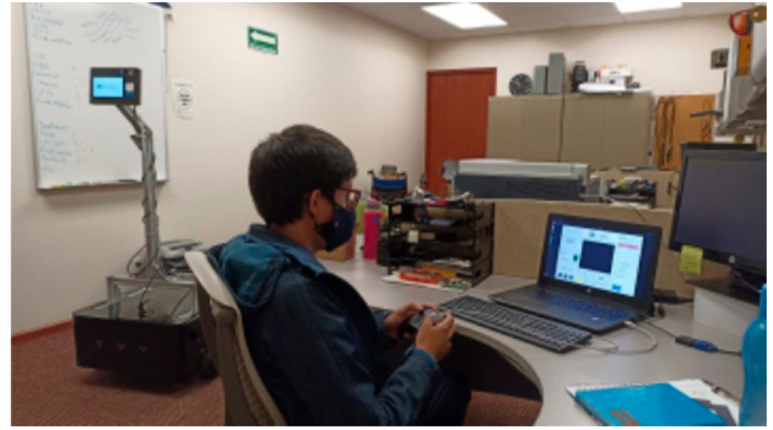
Figure 22. A teleoperator controlling the Robocov.